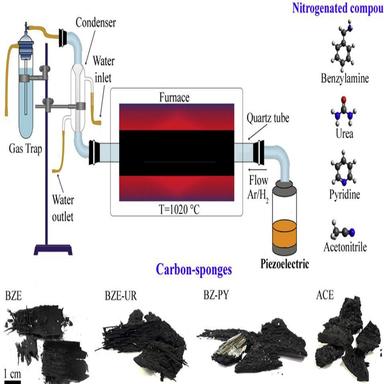
Schematic representation showing the chemical vapor deposition setup used to synthesize nitrogen-doped carbon fiber sponges (N-CFSs). The growth temperature is of 1020 C. Different N-CFSs were produced by varying the nitrogen precursors: benzylamine-ethanol 1:1 (BZE), BZE saturated with urea (BZE-UR), pyridine-benzylamine (BZ-PY), and acetonitrile-ethanol 1:1 (ACE). Ferrocene and thiophene are added to the solutions containing nitrogen precursors.